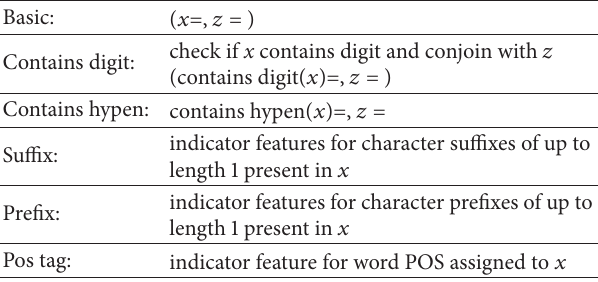
Table 3: Feature template used in unsupervised